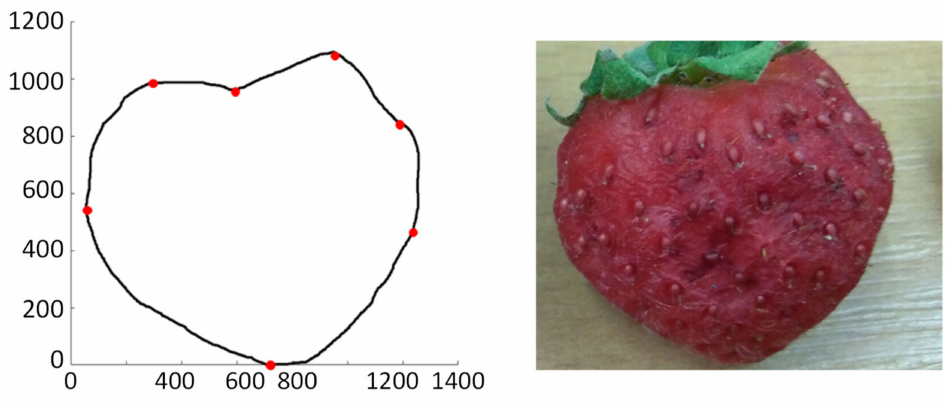
Figure 9. An example of undamaged fruit. Its contour is described by the sinquad 14.43.32.21.